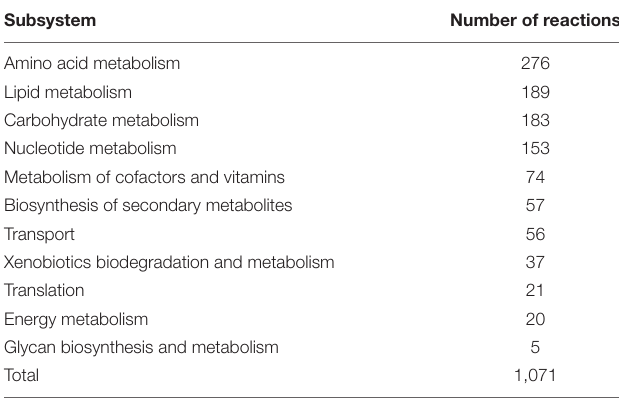
TABLE 4 | Reaction distribution in the largest WCC.